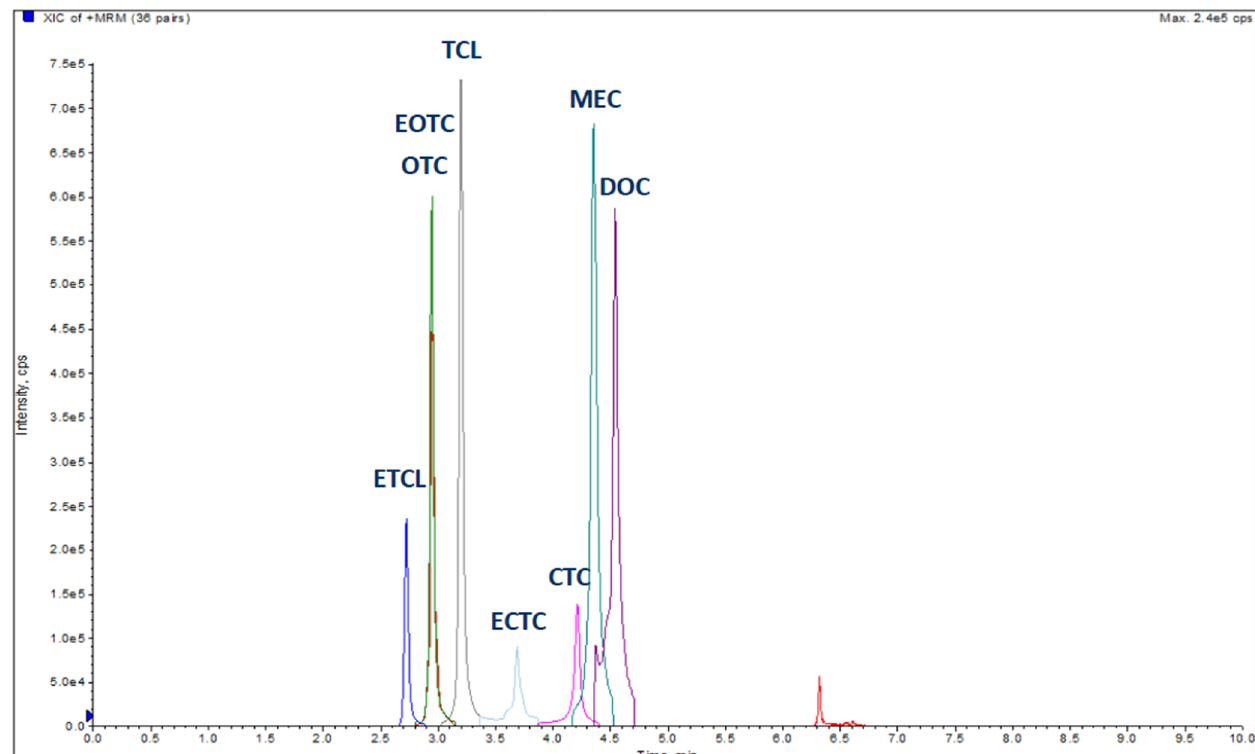
Figure 2. Extracted ion chromatogram (XIC) of TCLs in a sample fortified at 250 µg kg −1 . The acronyms are indicated in the chemicals and materials section (2.1). the red peak is a noise signal. ETCL = epitetracycline, EOTC = epioxytetracycline, OTC = oxytetracycline, TCL = tetracycline, ECTC = epichlortetracycline, CTC = chlortetracycline, MEC= methacycline, DOC = doxycycline.